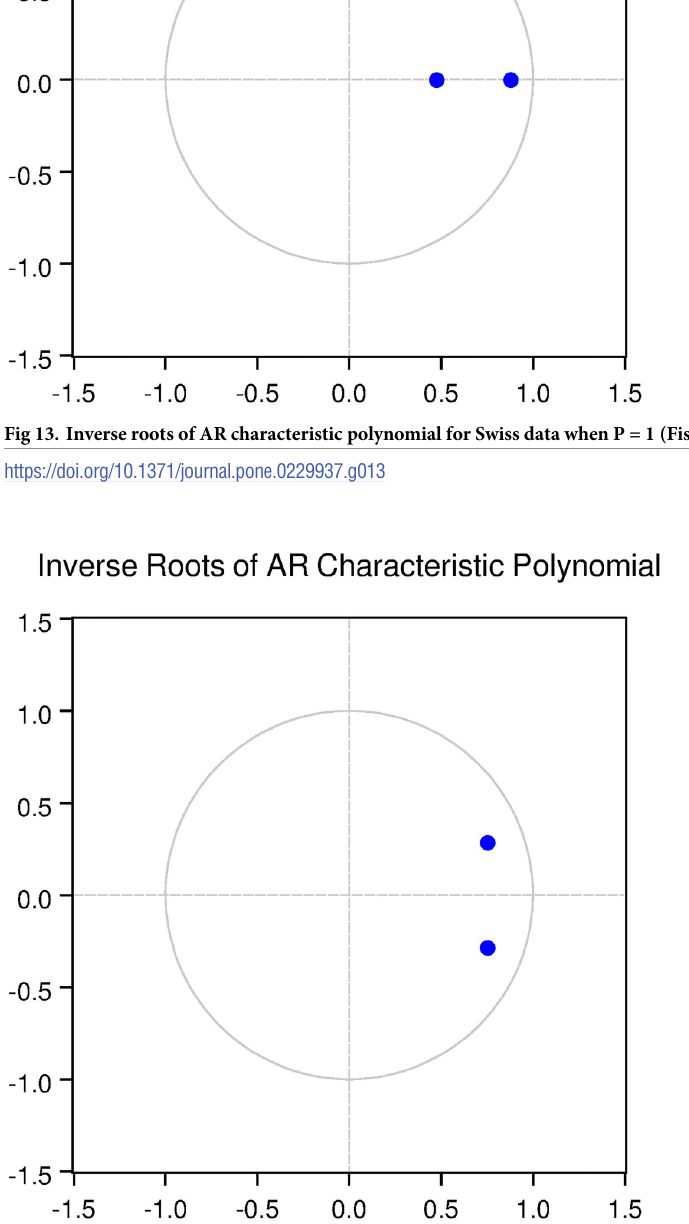
PLOS ONE | https://doi.org/10.1371/journal.pone.0229937 April 2,